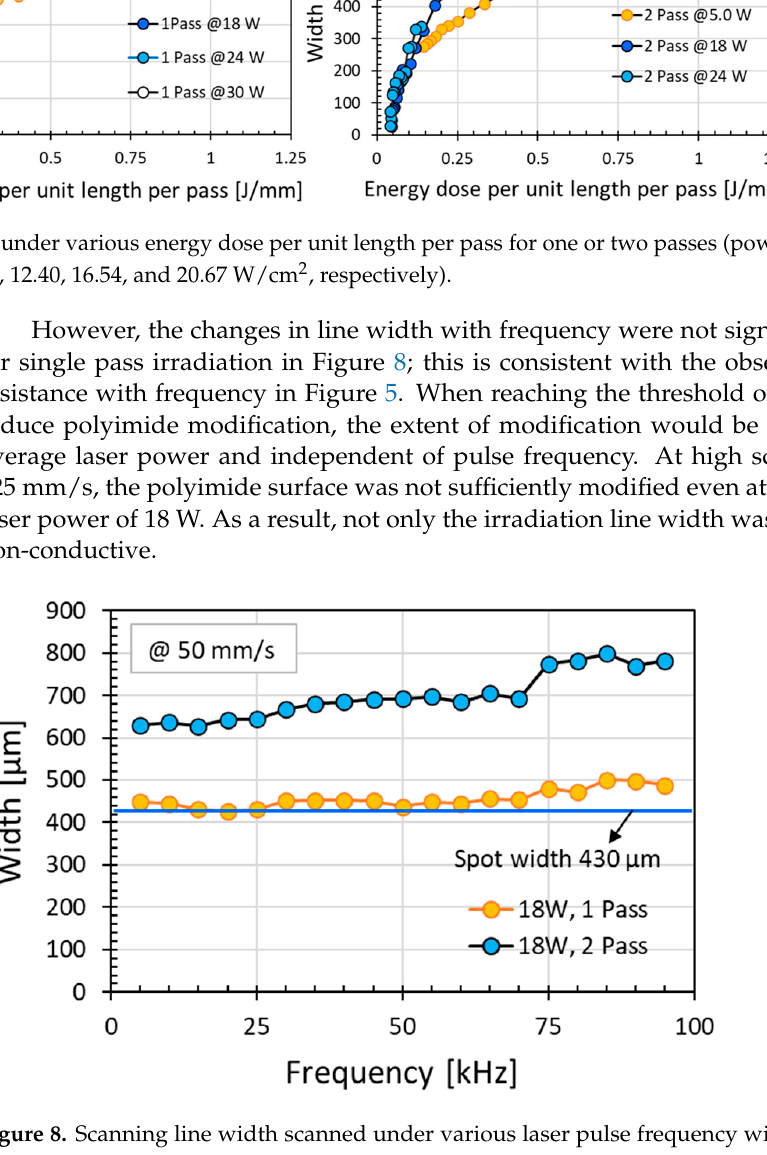
Figure 8. Scanning line width scanned under various laser pulse frequency with energy dose per unit length per pass of 0.36 J/mm for one or two passes obtained at power of 18 W (12.40 W/cm 2 ) and speed of 50 mm/s. The laser spot width is indicated in the figure.